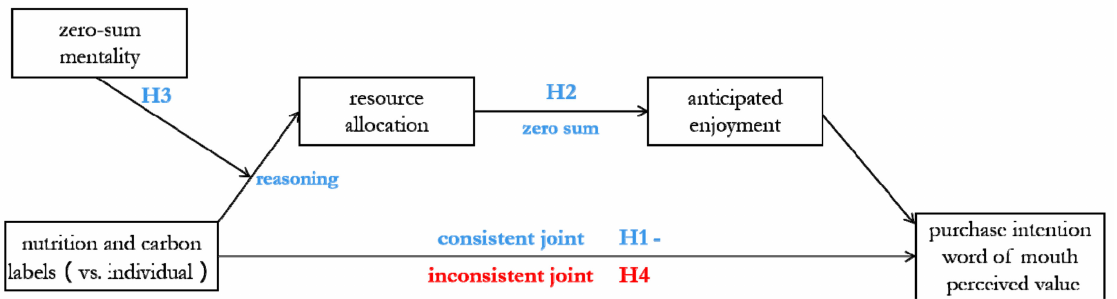
Figure 1. The main framework of the